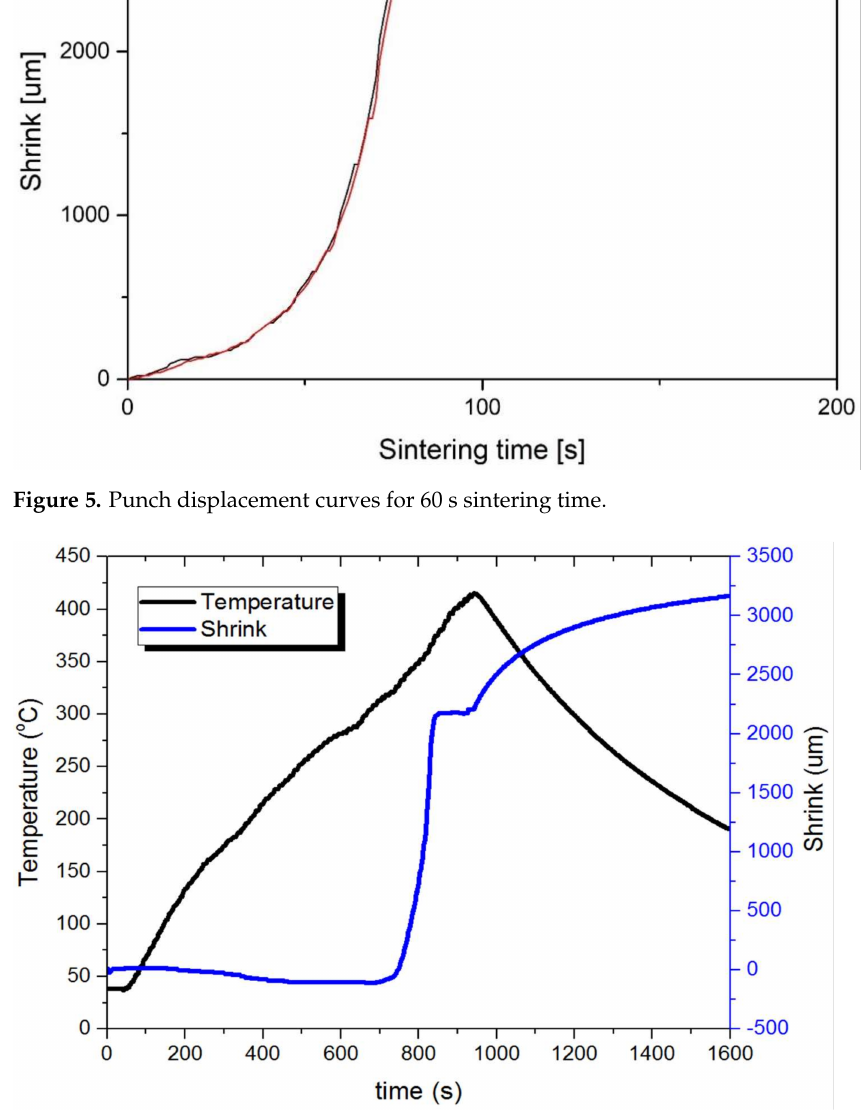
Figure 6. U-FAST process readout for gear wheel